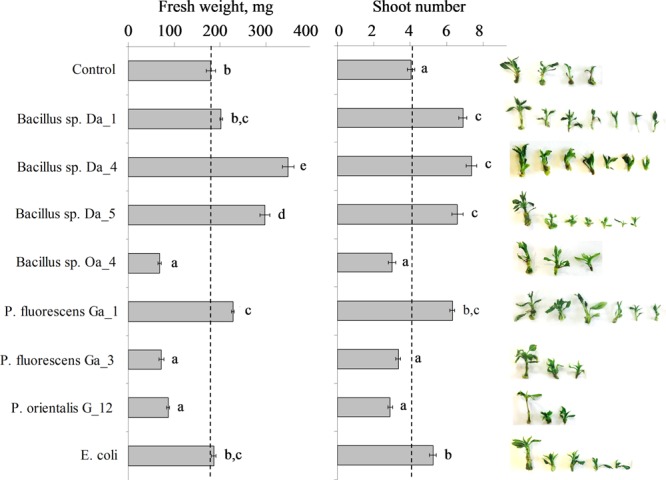
Combined weight of parent and auxiliary apple shoots (left panel) and the auxiliary shoot propagation coefficient (middle panel). Apple shoots were inoculated with 3 μL of each strain suspended at ∼107 cfu/ml in Murashige-Skoog medium. After 3 weeks of co-cultivation, the combined weight of parent and auxiliary shoots and the propagation coefficient represented by an average number of auxiliary shoots that developed on the parent shoot were assessed. A dashed line indicates the mean value of the control shoots. The insert on the right shows a representative sample of auxiliary shoots derived from one parent shoot. Data are presented as mean and SEM of a total of 40–55 shoots from three independent experiments. Means followed by the same letter are not significantly different (p < 0.05).